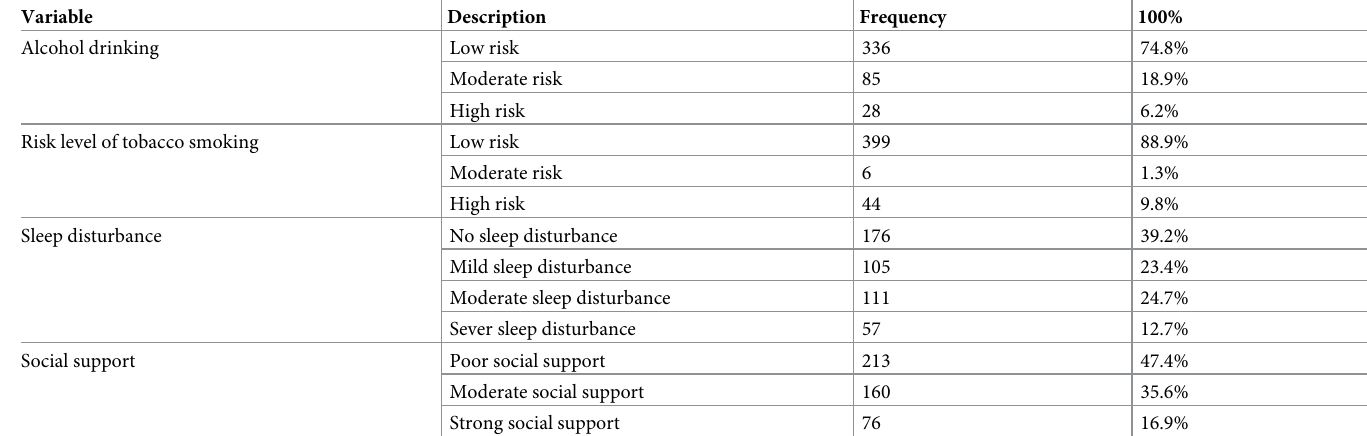
Table 4. Psychosocial and behavioral factor among adult cancer patients receiving cancer treatment at oncology unit in Amhara region, Ethiopia, 2022 (N = 449).